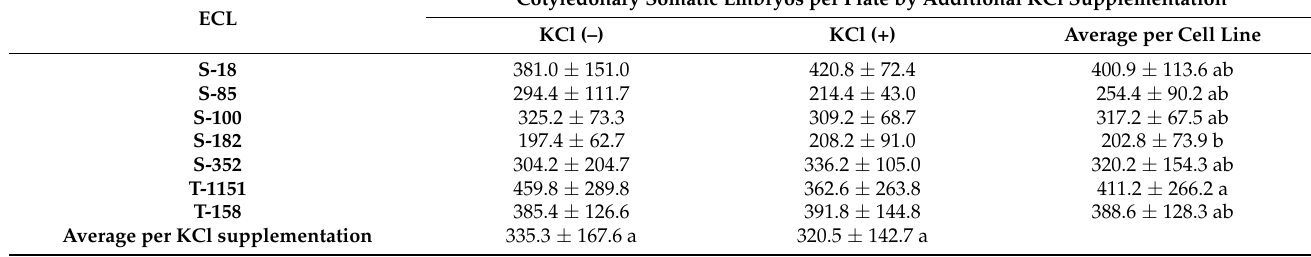
Table 7. Effect of potassium chloride (KCl) supplementation on somatic embryo maturation efficiency of sugi embryogenic cell lines (ECLs). Data are present as the mean ± SD (standard deviation) of the number of cotyledonary somatic embryos per plate from five replicates for each ECL matured on medium with (+) or without (–) additional KCl supplementation.